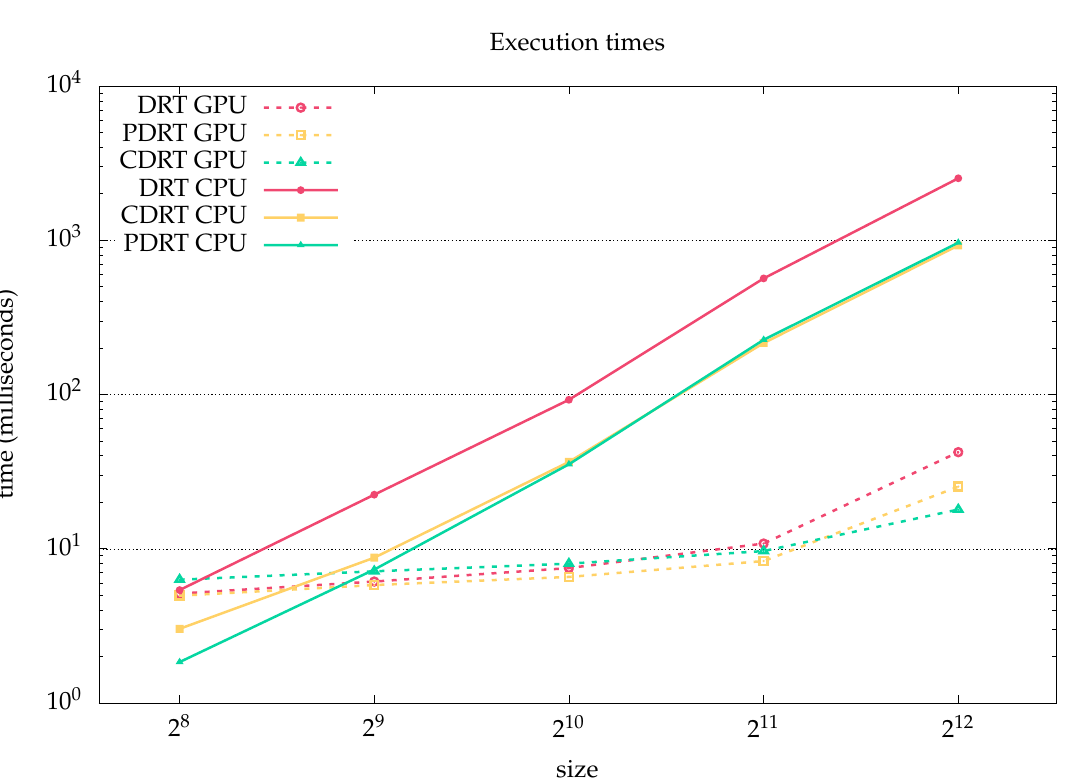
Figure 15. Log–log representation of execution times (in milliseconds) for multi-scale DRT algorithms on CPU and a NVIDIA Geforce GTX 1080 GPU. DRT stands for conventional DRT, whilst CDRT and PDRT are our proposed central and periodic